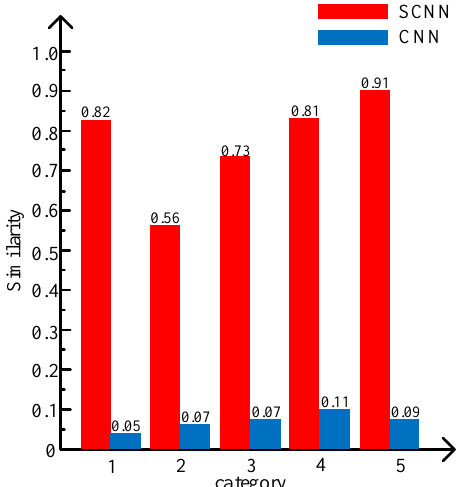
Figure 7. Mean similarity between features of the same